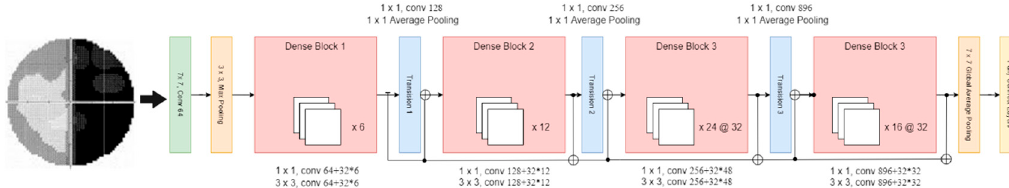
Figure 8. DenseNet